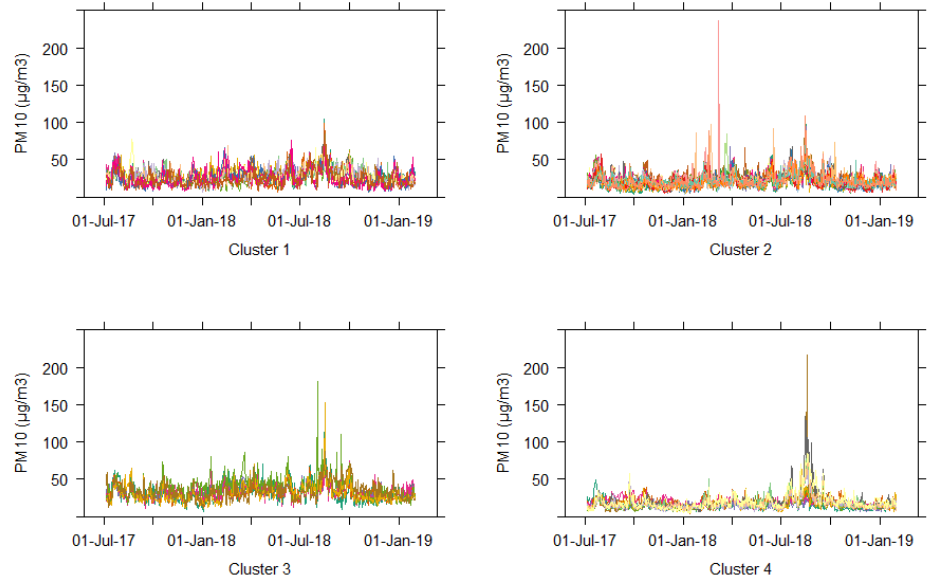
Figure 4. Time series plots for each cluster formed based on DTW and k-Means for daily average PM 10 time series data.